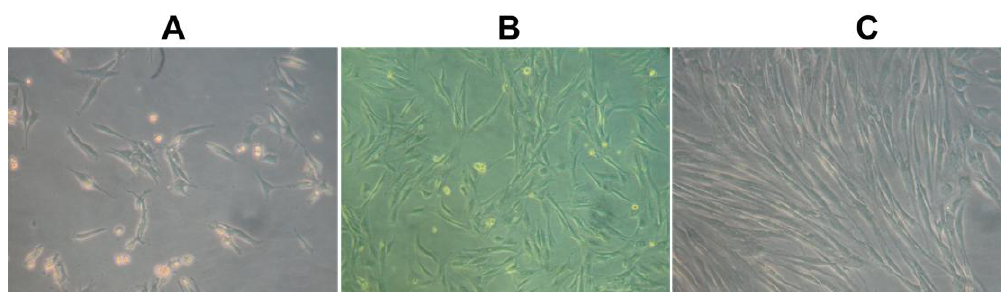
Figure 1. Morphological characteristics of isolated porcine skeletal muscle satellite cells under microscope with white light (×100). (A) Proliferating muscle satellite cells at low density stage. (B) Proliferating muscle satellite cells at high density stage. (C) Differentiated myotubules from muscle satellite